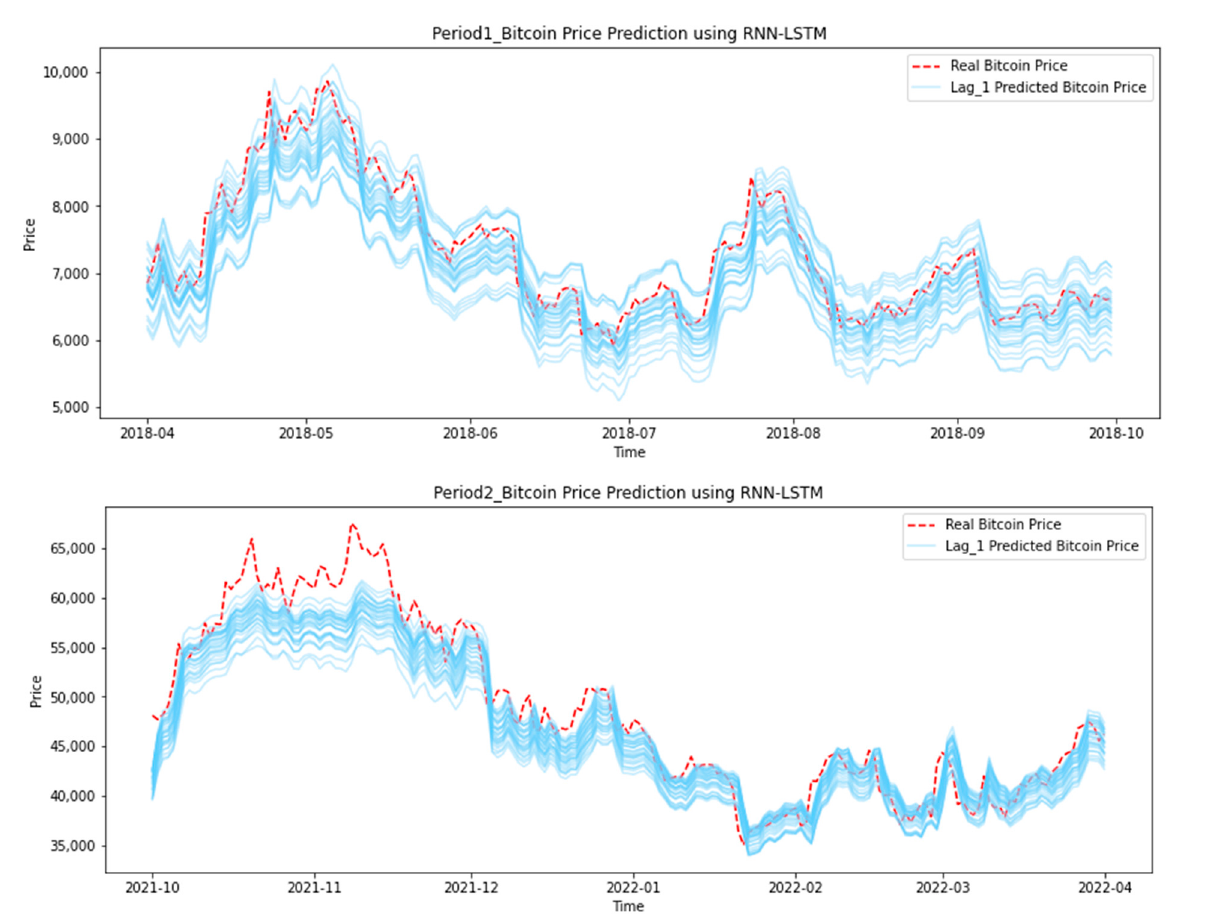
Figure 12. Comparison of the true price of Bitcoin and predicted price based on different models. (LSTM).